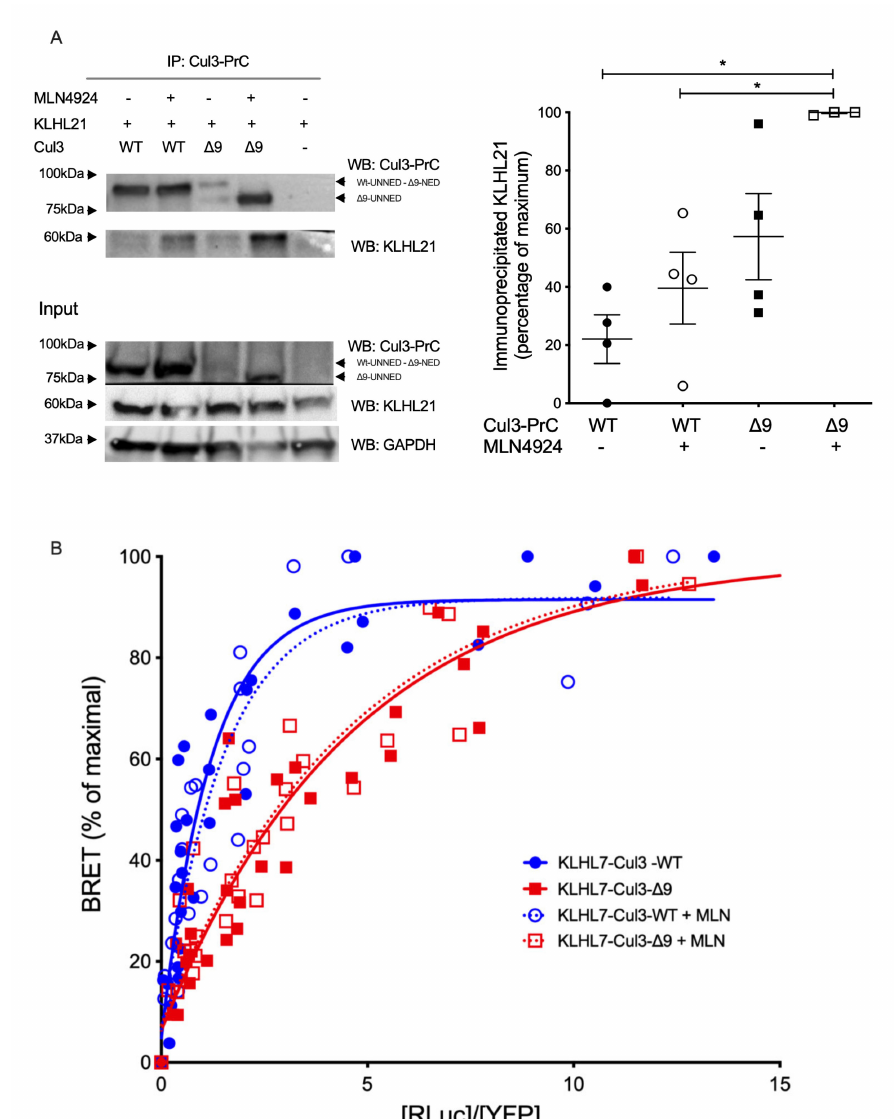
Figure 6. Interactions of other BTB-proteins (KLHL7 and KLHL21) with CUL3-WT and CUL3- ∆ 9. ( A ). Flp-In TM T-REx TM 293 cells (Invitrogen), stably transfected with PrC-CUL3-WT or PrC-CUL3- ∆ 9, were induced (or not) with tetracycline (10 µ g/mL) for 16 h and treated (or not) with MLN4924 (1 µ M) for 5 h. Co-immunoprecipitation of PrC-CUL3 was performed using HPC4-agarose beads (Roche) followed by SDS-PAGE and transfer to nitrocellulose. The left shows a representative gel of the co-immunoprecipitation experiment blotted with the polyclonal HPC4 (cell signaling) and KLHL21 (Invitrogen) antibodies. On the bottom, a Western blot of the same cellular extracts for CUL3, KLHL21, and GAPDH is shown. On the left, a scatter plot of the results obtained for three experiments is presented. The results are expressed as the percentage of the maximal ratio of immunoprecipitated KLHL21/CUL3. Statistical comparisons used the Kruskal–Wallis test on KLHL21/CUL3 ratios (* = p < 0.05). ( B ). The interaction of Luc-KLHL7 with YFP-CUL3-WT and YFP-CUL3- ∆ 9 was analyzed by BRET experiments, as shown in Figure 2. Similar hyperbolic curves were obtained with CUL3-WT and CUL3- ∆ 9 with non-significant different BRET 50 (1.07 ± 0.37 and 2.71 ± 0.89, respectively, n = 3, p = 0.195). In addition, interestingly, deneddylation of CUL3-WT or CUL- ∆ 9 with MLN4924 did not change these curves at all (BRET 50 1.27 ± 0.45 and 2.41 ± 0.66, respectively, n = 3, p = 0.226). Statistical comparisons used the Student’s t